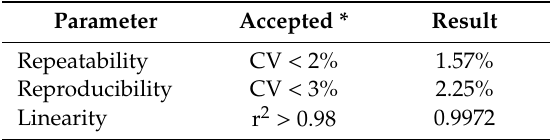
Table 2. Variation coefficient of repeatability and reproducibility tests and determination of the coefficient of linearity.